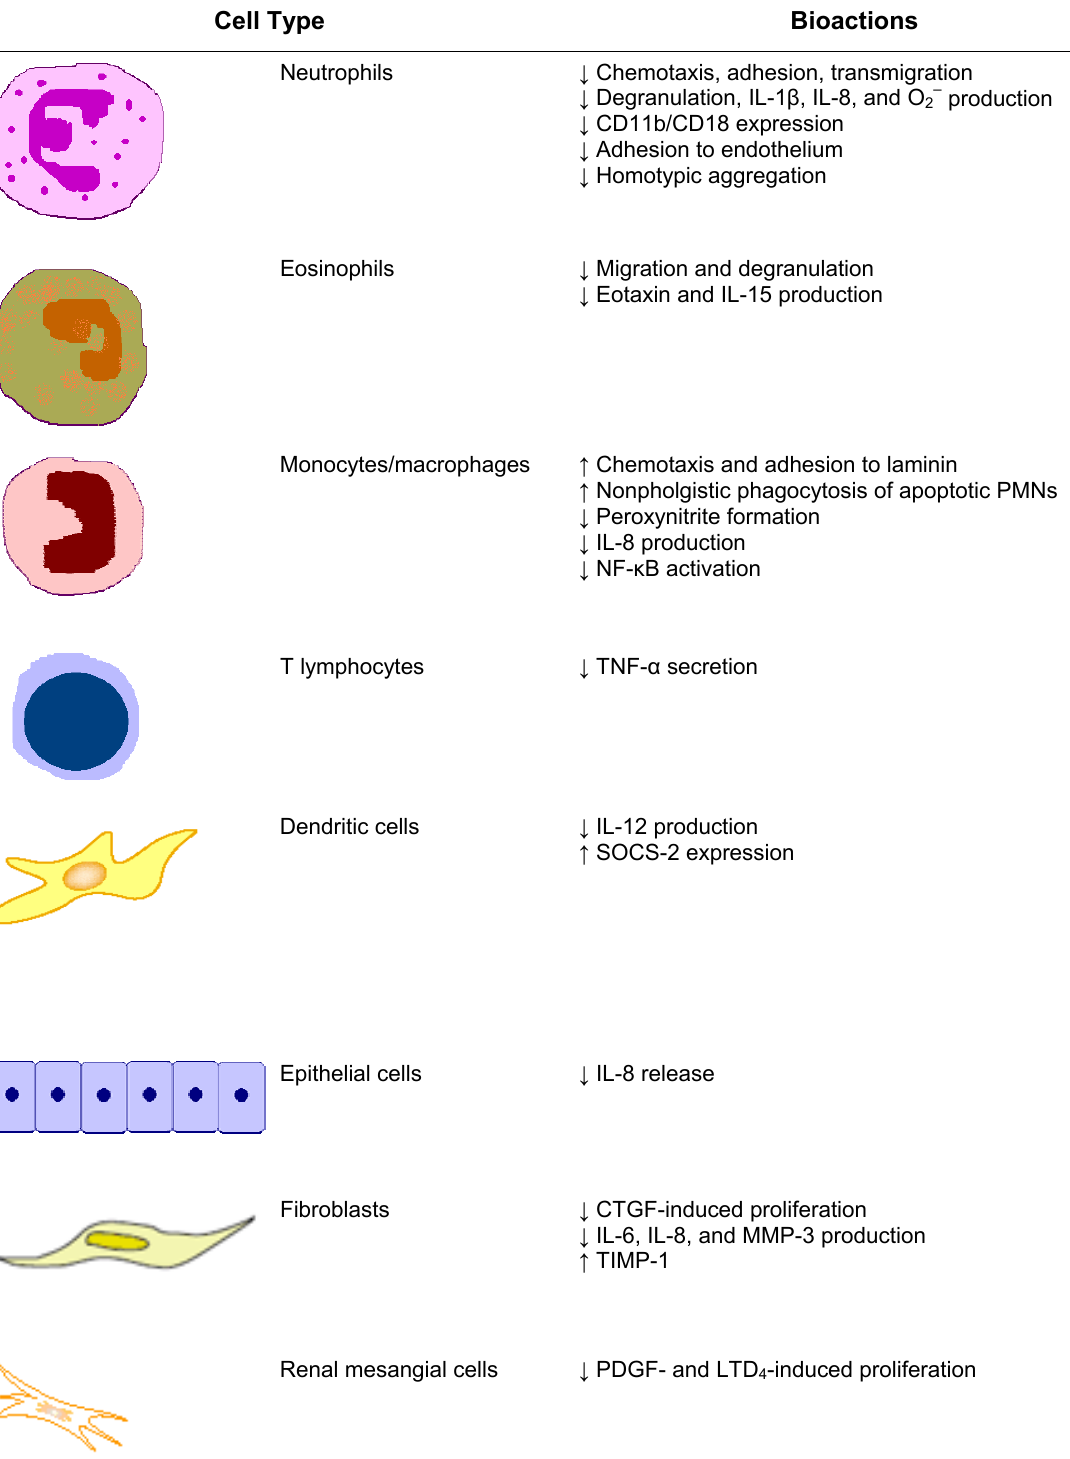
and ATL Most Relevant Bioactions in ALX-Expressing Cells LXA 4 Cell Type